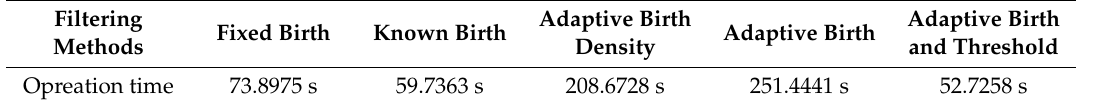
Table 4. Operation time of different filters with a clutter rate of 50.